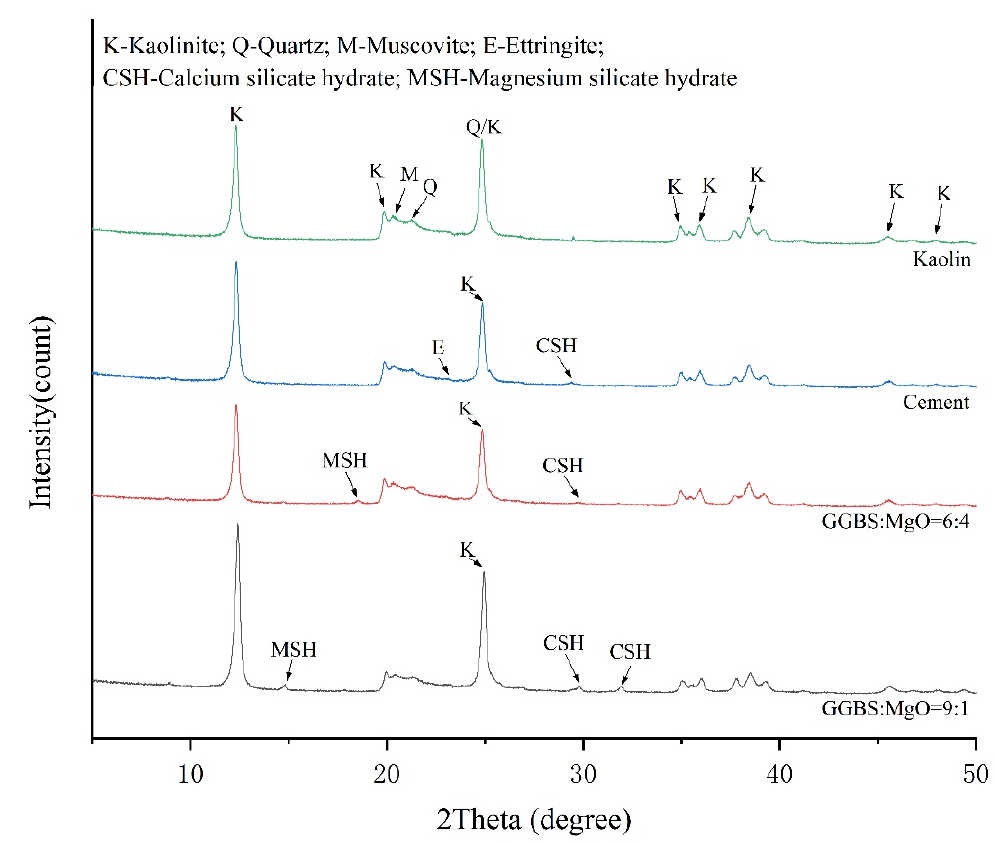
Figure 9. XRD patterns of kaolin and Mg-sulfate-soils treated with cement, GGBS:MgO = 6:4, and 9:1 after soaking.